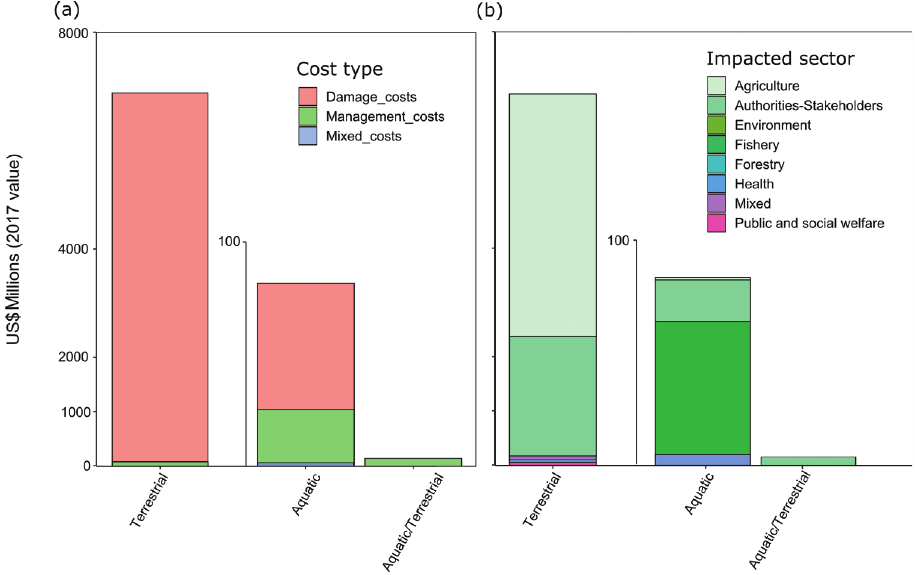
Figure 2. Economic cost of IAS in Argentina in each type of environment by a cost type and b impacted Table 1. List of invasive species with reported economic costs for Argentina. Data sourced from the InvaCost database (Diagne et al. 2020b).